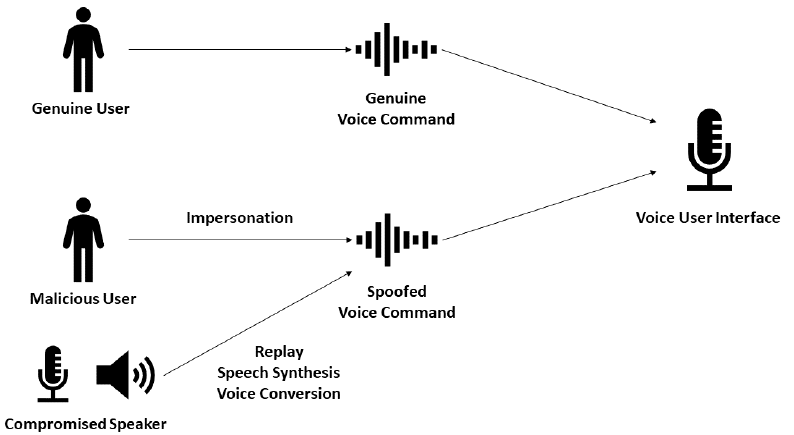
Figure 1. Attack examples for voice-triggered financial